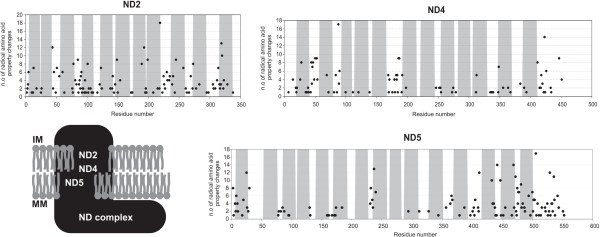
Amino acid property variation in NADH dehydrogenase subunits ND2/3/5. Topological assignment of the sites that present a high number of radically changing properties under positive-destabilizing selection in three subunits of the NADH dehydrogenase complex that are suggested to be proton pumping devices. The transmembrane domain average prediction is shown in grey (for details see Material and Methods section). MM: mitochondria matrix; IM: intermembrane space.